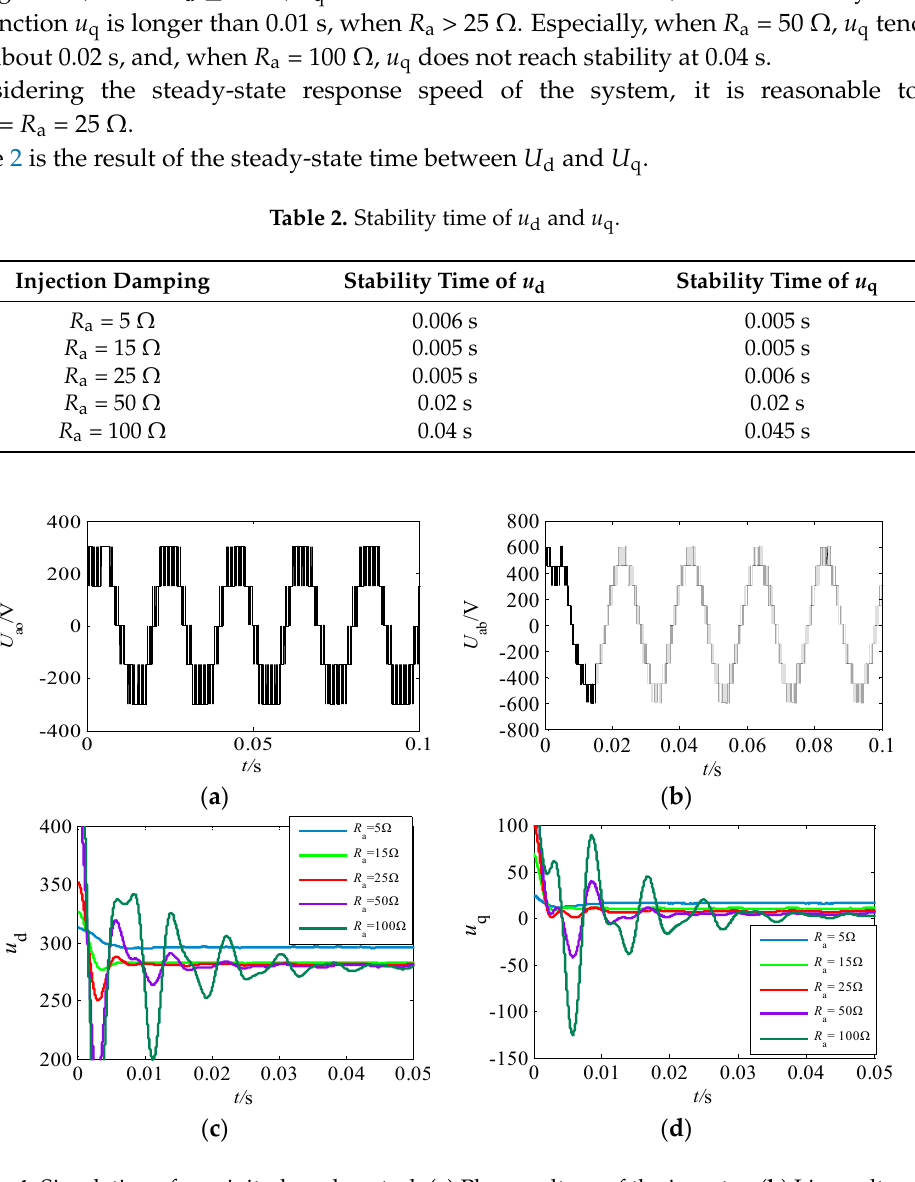
Figure 4. Simulation of passivity-based control. ( a ) Phase voltage of the inverter; ( b ) Line voltage of the inverter; ( c ) The output function u d , and ( d ) The output function u q .